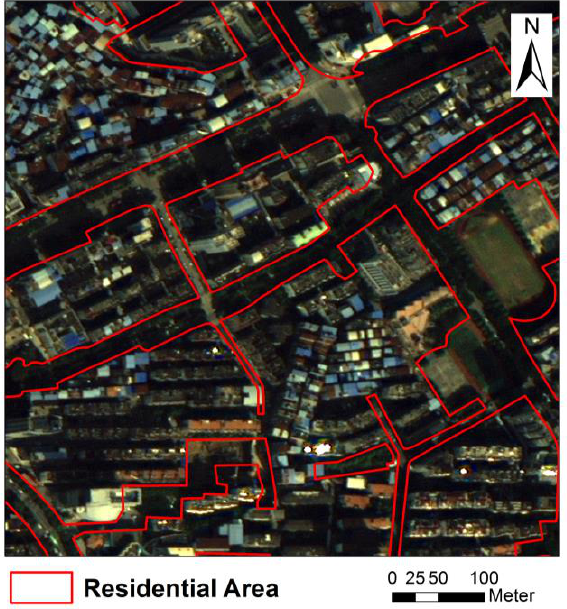
Figure 1. Zooming view of TripleSat and Residential Layer © Satellite Imaging Corporation Copyright 2017